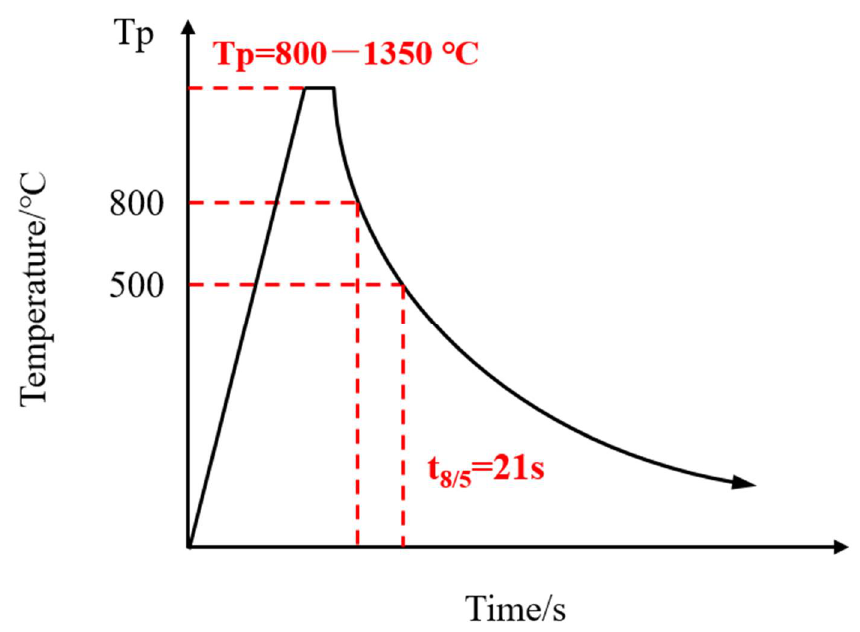
Figure 2. Welding thermal cycle test process with the different peak temperature.